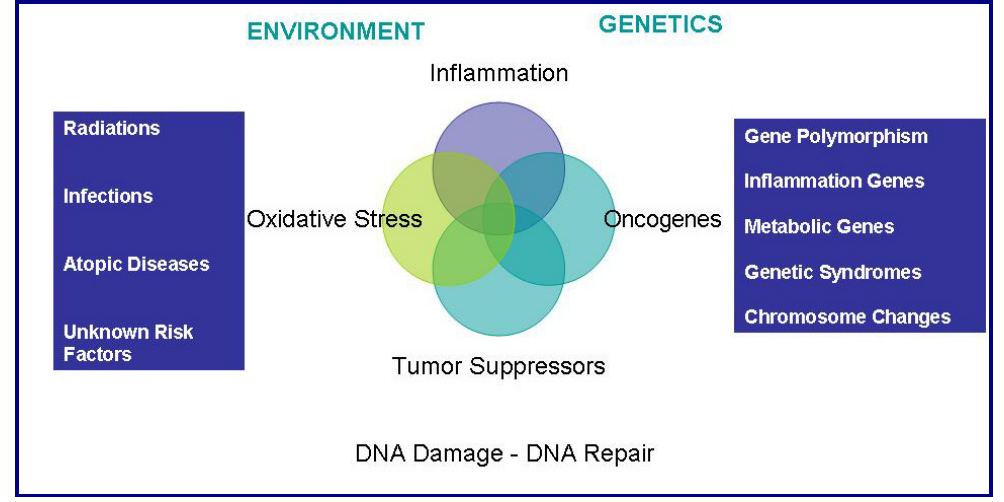
Figure 6. A possible interaction between environmental and genetic factors in gliomagenesis. Mediators of inflammation and oxidative stress pathways interacts with oncogenes and tumor suppressor genes influencing the evolution toward neoplastic phenotype by unbalancing the DNA repair/damage